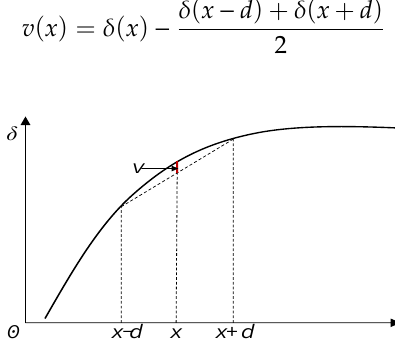
Figure 5. Relationship between versine and displacement profile.